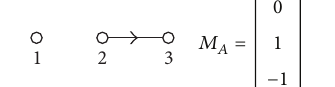
Figure 2: A disconnected graph and its incidence